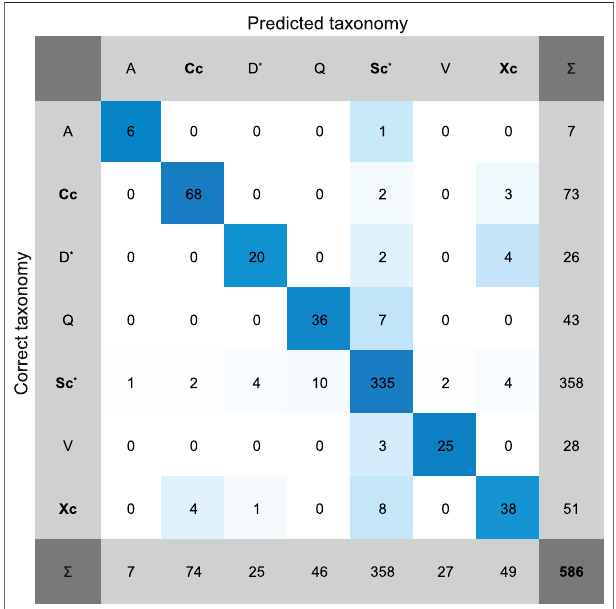
FIGURE 3 | Confusion matrix plot of the results of the NN taxonomic classi fi cation with simpli fi ed taxonomy of simulated LSST observations. See Figure2 fortheexplanationofthematrix,and Table3 forsimpli fi edtaxonomy labels.